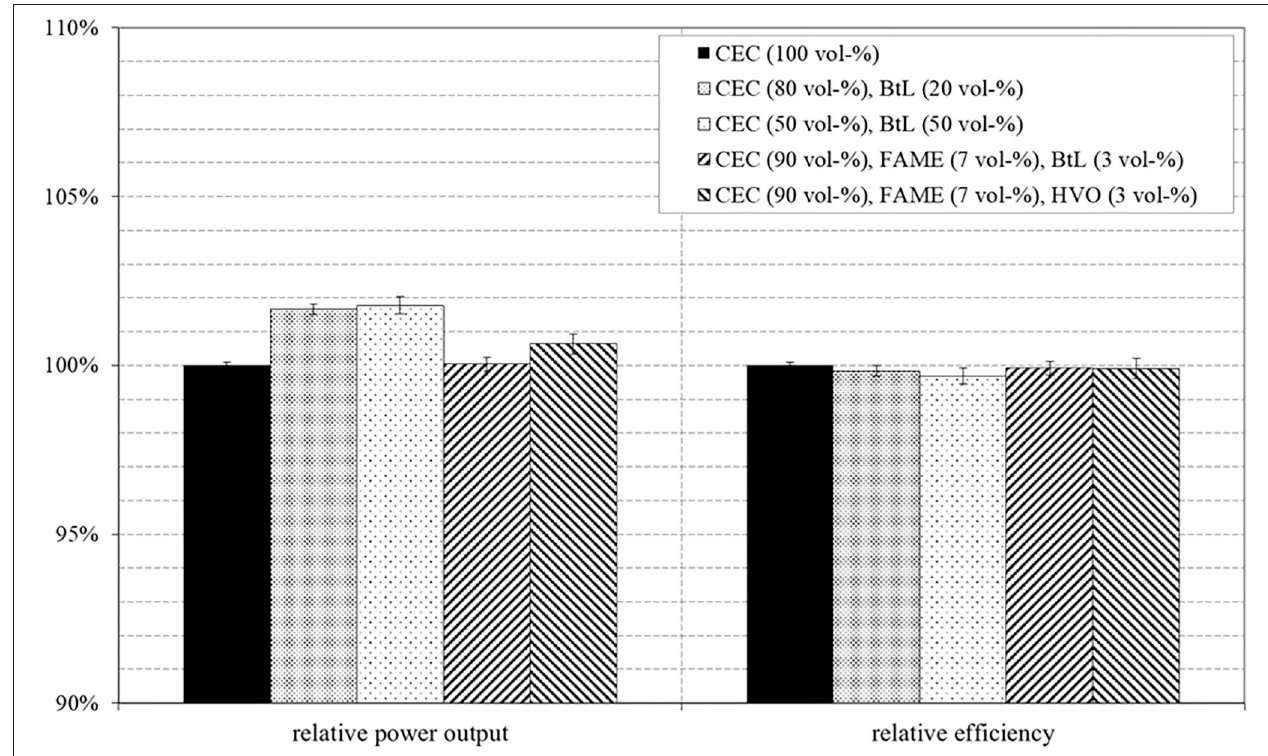
FIGURE 13 | Relative power output and relative efficiency related to the results of pure CEC diesel, at 2,000 min − 1 and 23.2 bar